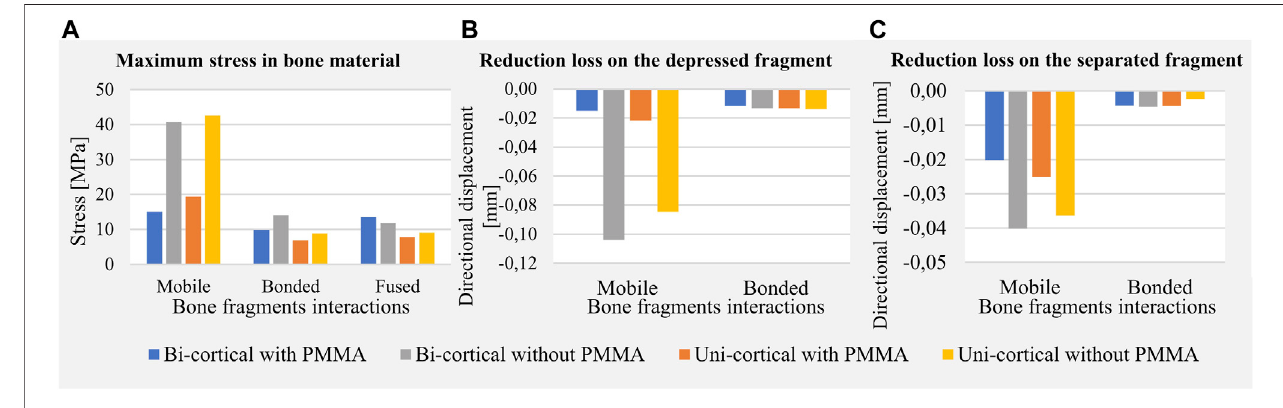
TABLE 3 | Quantitative assessment of stabilization methods on the tibial plateau fracture stability.